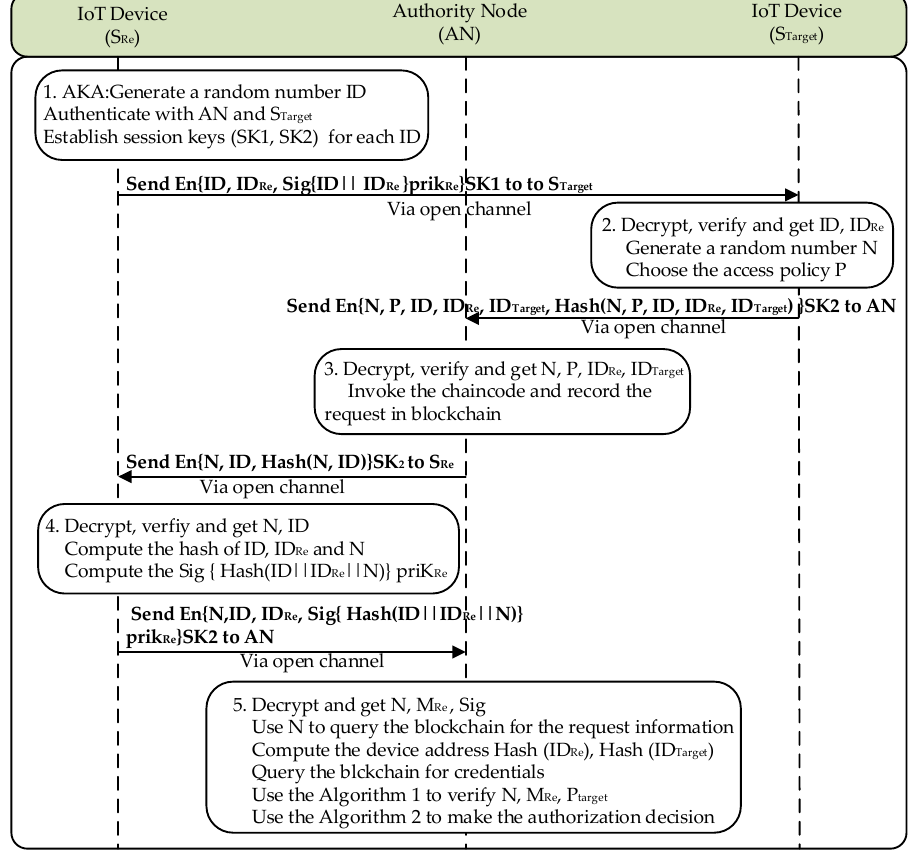
Figure 5. The authorization process of our proposed attribute-based access control scheme between two devices using a blockchain in an IoT